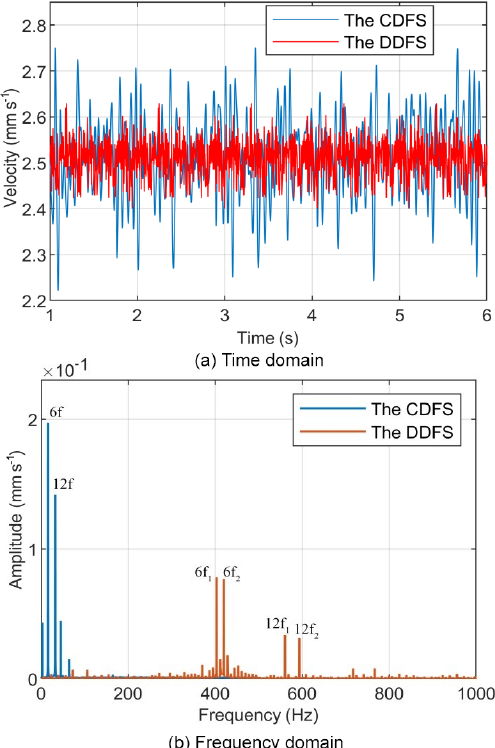
Figure 8. Comparison of the table velocity fluctuations of CDFS and DDFS when the nut servo motor speed is 800rpm in the DDFS.